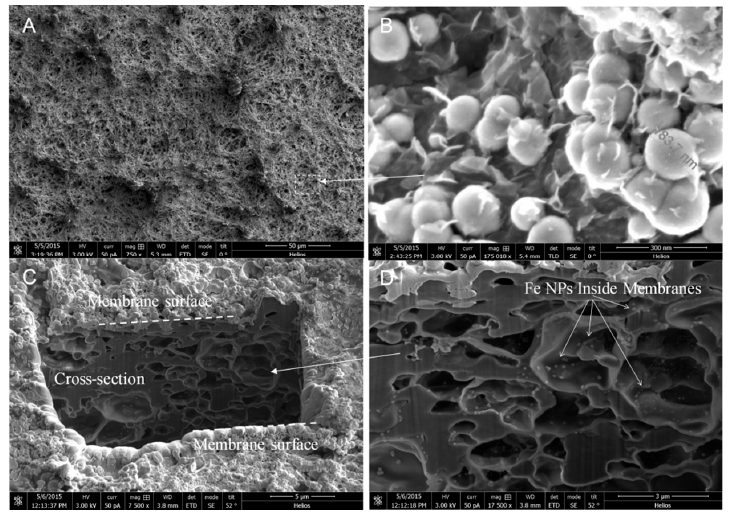
Figure 5. Iron-functionalized N-PVDF-PAA membrane (non-spongy, full-scale) surface and cross-sectional images obtained by FIB. Sodium acrylate (NaAc) was used as the monomer during the polymerization.